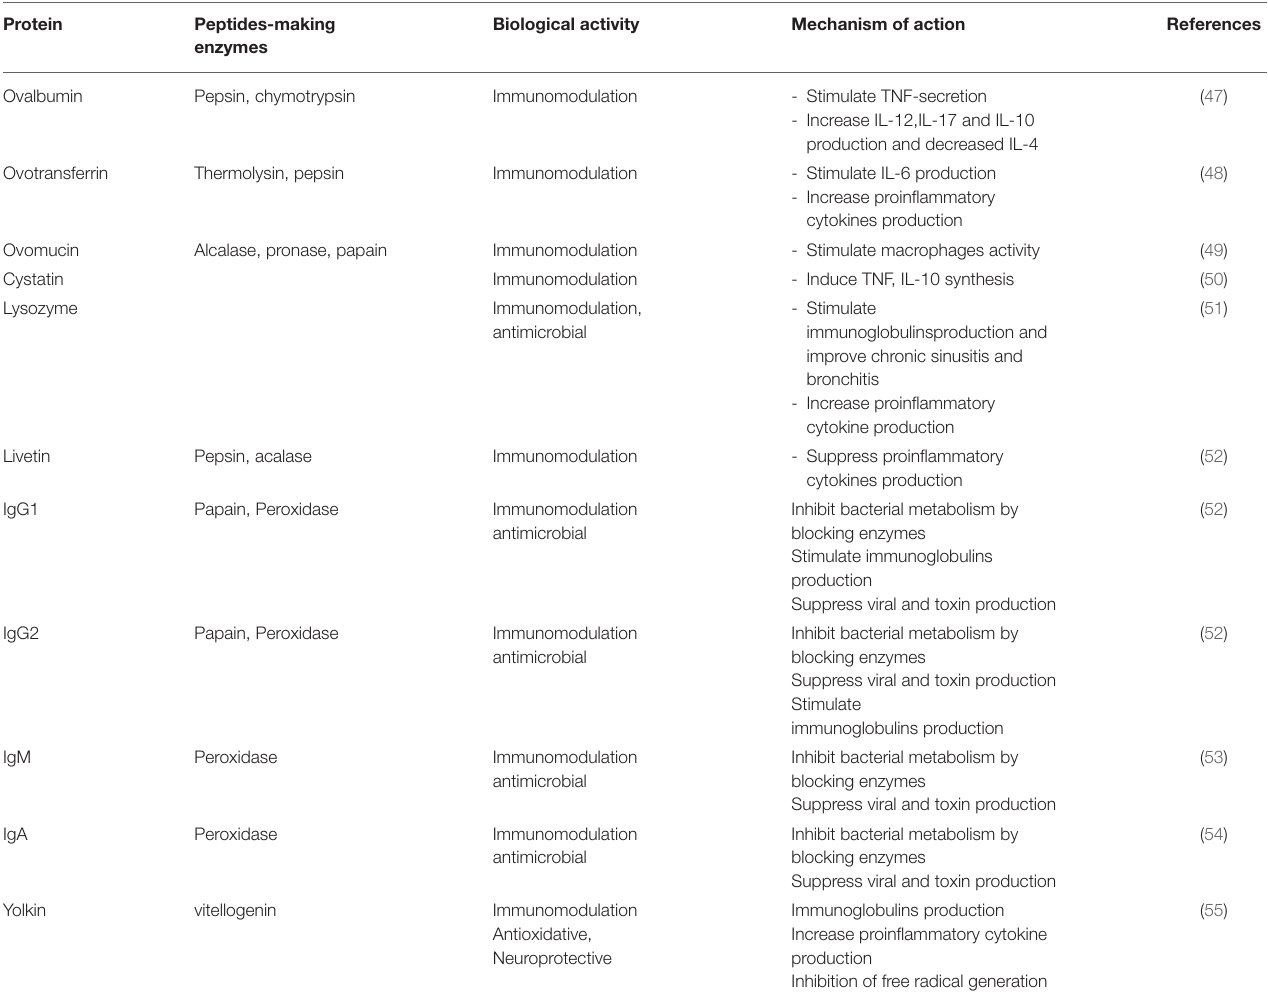
TABLE 1 | Egg proteins and peptides with immunomodulatory activity.